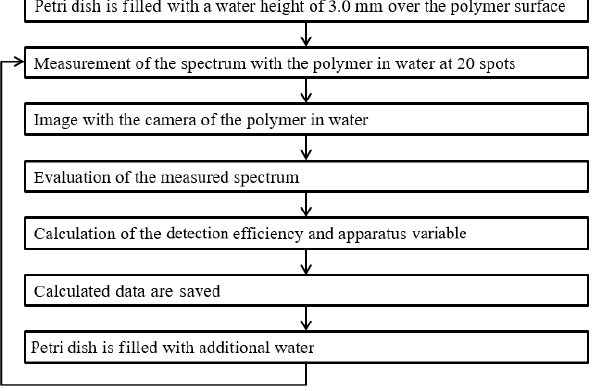
Figure 2. Flowchart for the measurement procedure of the polymer foils in 3.0, 4.5, 6.0, 7.0 and 8.0mm water depth. Table 1. Experimental determined values for the detection effi- ciency and apparatus variable of the polymers PA, PE and